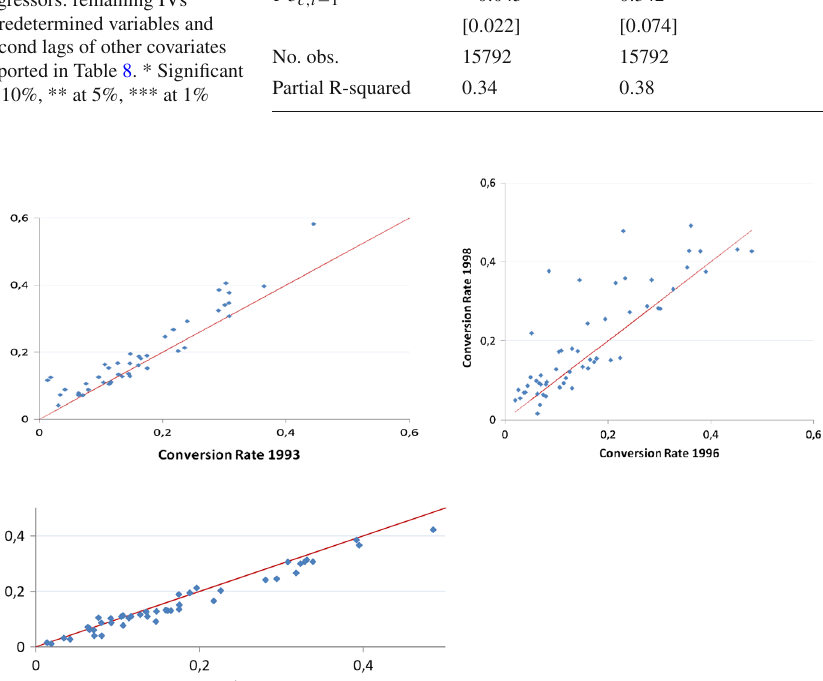
there was no change in EPL regulations. As can be inspected, the observations are neither above the 45 degree line (as in the first two reforms) nor below it (as in the last reform).